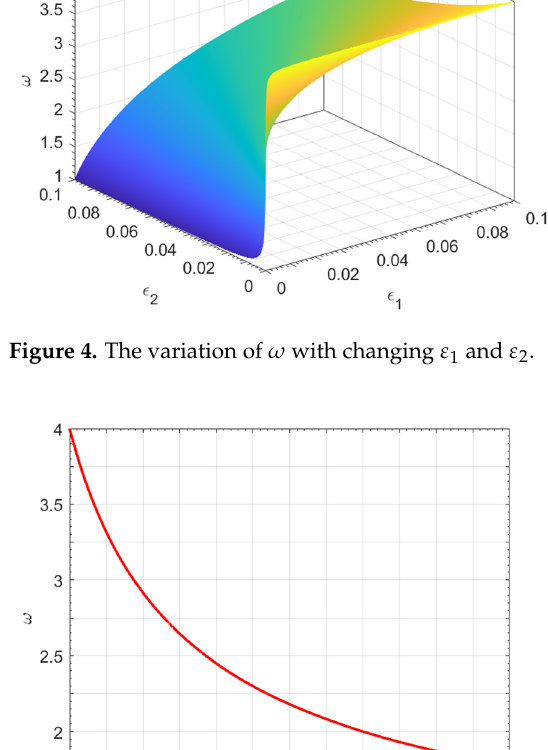
Figure 5. The variation of ω with changing η .